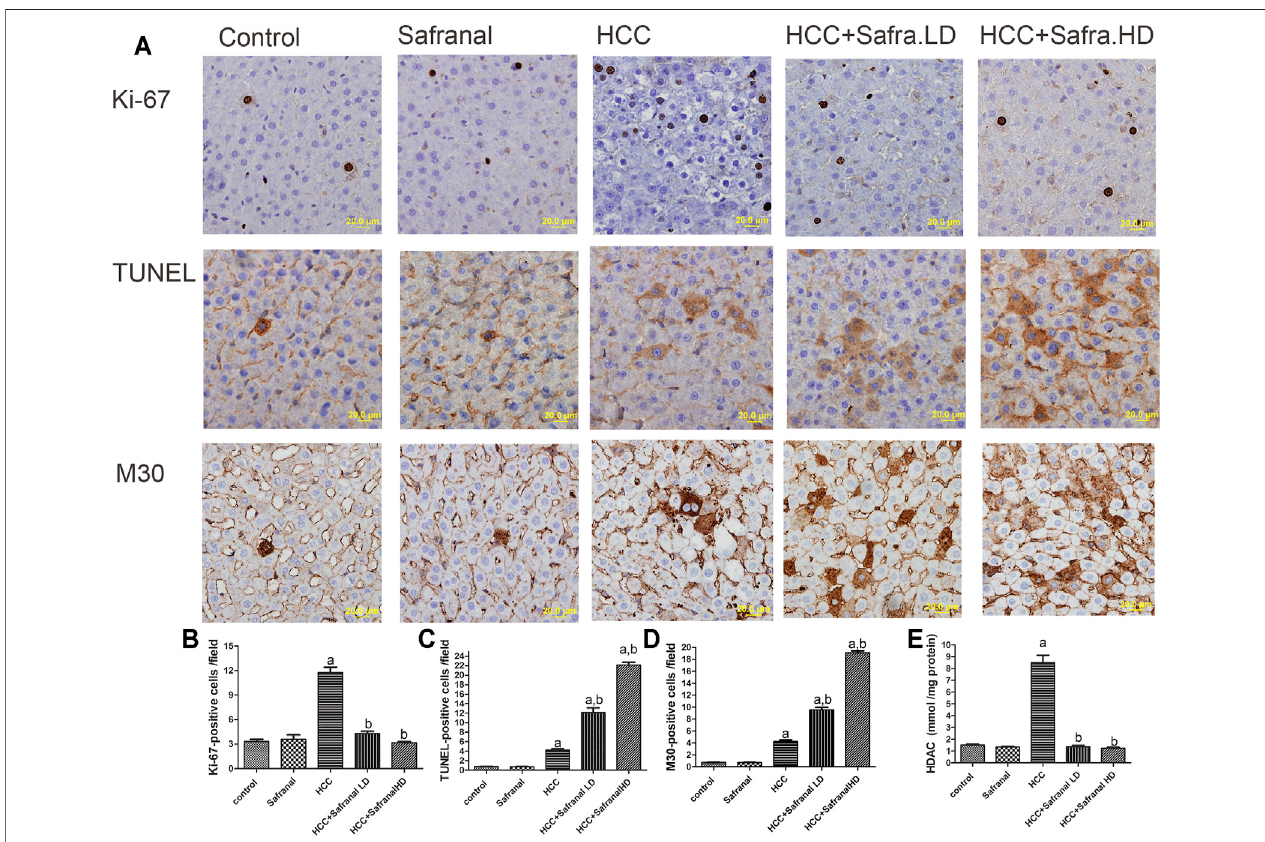
FIGURE 3 | Effects of safranal on proliferation (Ki-67) and apoptotic cell death (TUNEL and with M30) and HDAC activity in rat livers. (A) The upper panel includes representative images of immunohistochemical staining with Ki-67, TUNEL, and M30 in liver sections from all the groups (scale bar = 20 µm). The bottom panel represents quantitative analysis of Ki-67 (B) , TUNEL (C) , and M30 (D) positive cells as well as HDAC activity (E) , which is expressed in mmol/mg protein. The positive expression in each section was calculated by counting the number of brown staining in 10 fi elds at ×400 magni fi cations, then the number of positive cells/ fi eld. Values expressed as mean ± SEM for six animals in each group. Signi fi cance was determined by one-way ANOVA followed by Dunnett ’ s t -test: a p < 0.05 vs. control group, b p < 0.05 vs. HCC group.